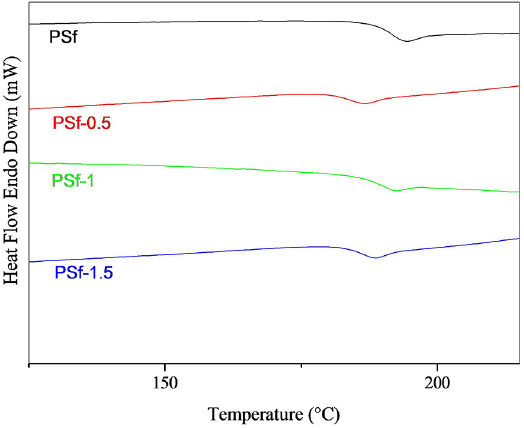
Figure 4: DSC thermograms of the membranes.